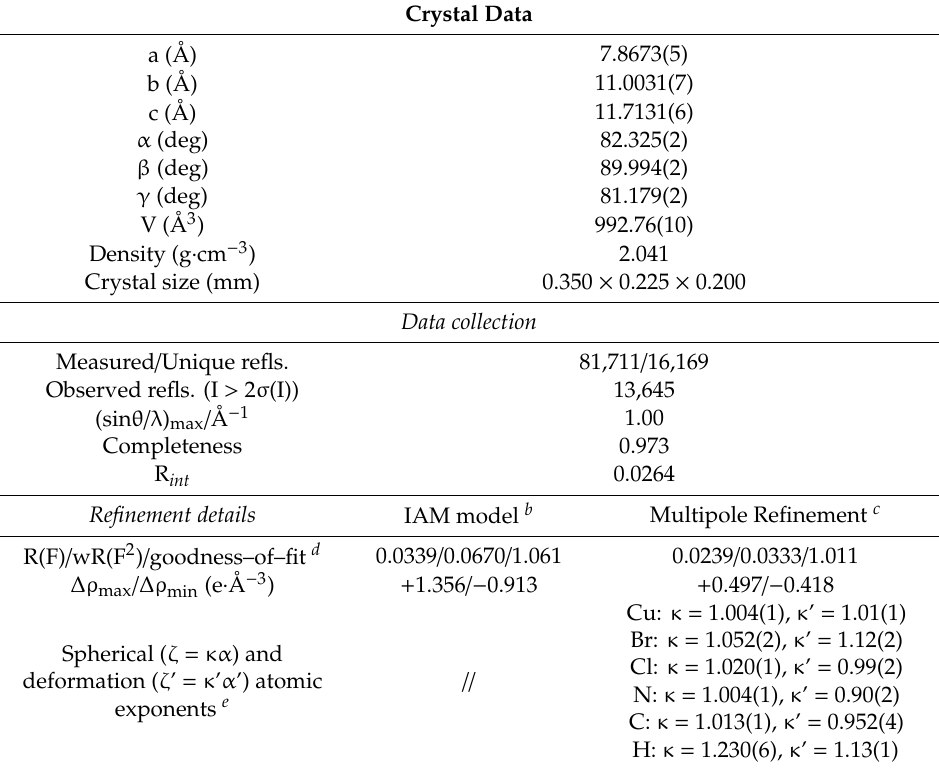
Table 1. Data collection statistics and relevant refinement details of CDCQB a at T = 100